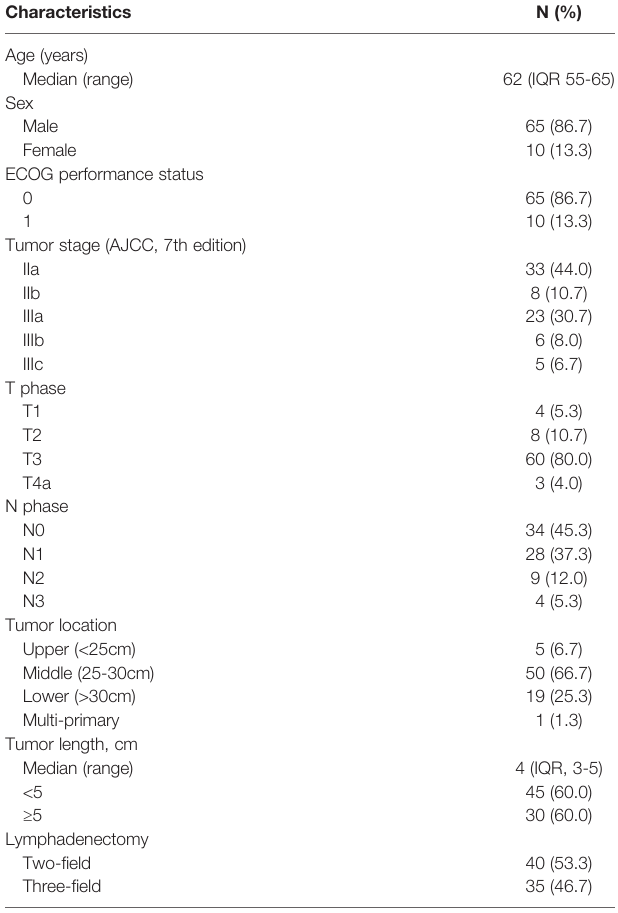
TABLE 1 | Patient Characteristics (N =